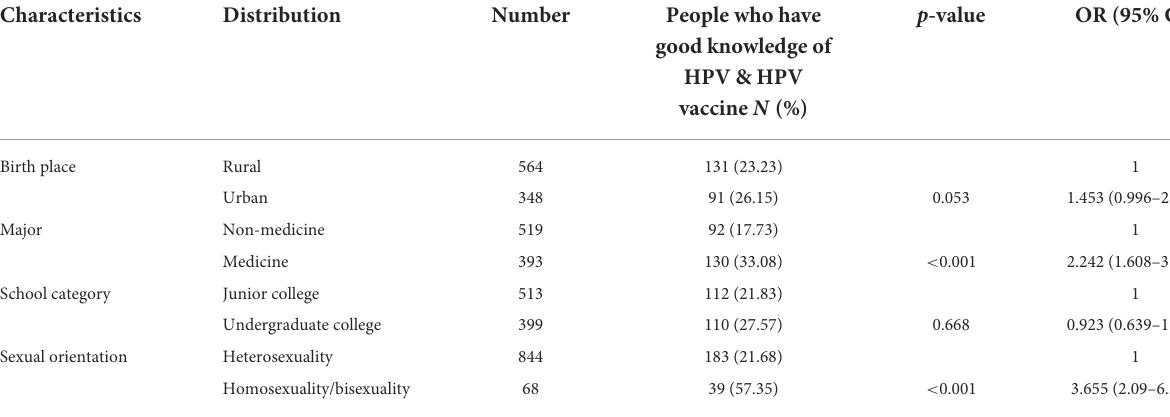
TABLE 3 Logistic multivariate analysis of HPV vaccine awareness rate among male college students in Nanjing, China.